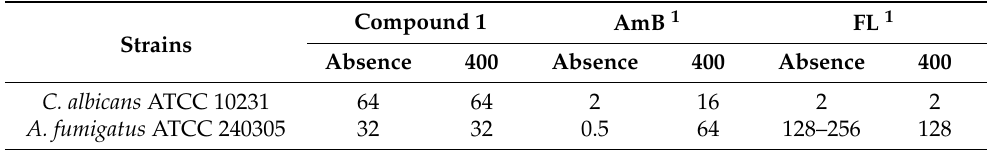
Table 2. Minimal inhibitory concentration values (MIC, µ g/mL) in the absence and presence of ergosterol at 400 µ g/mL against two reference strains.